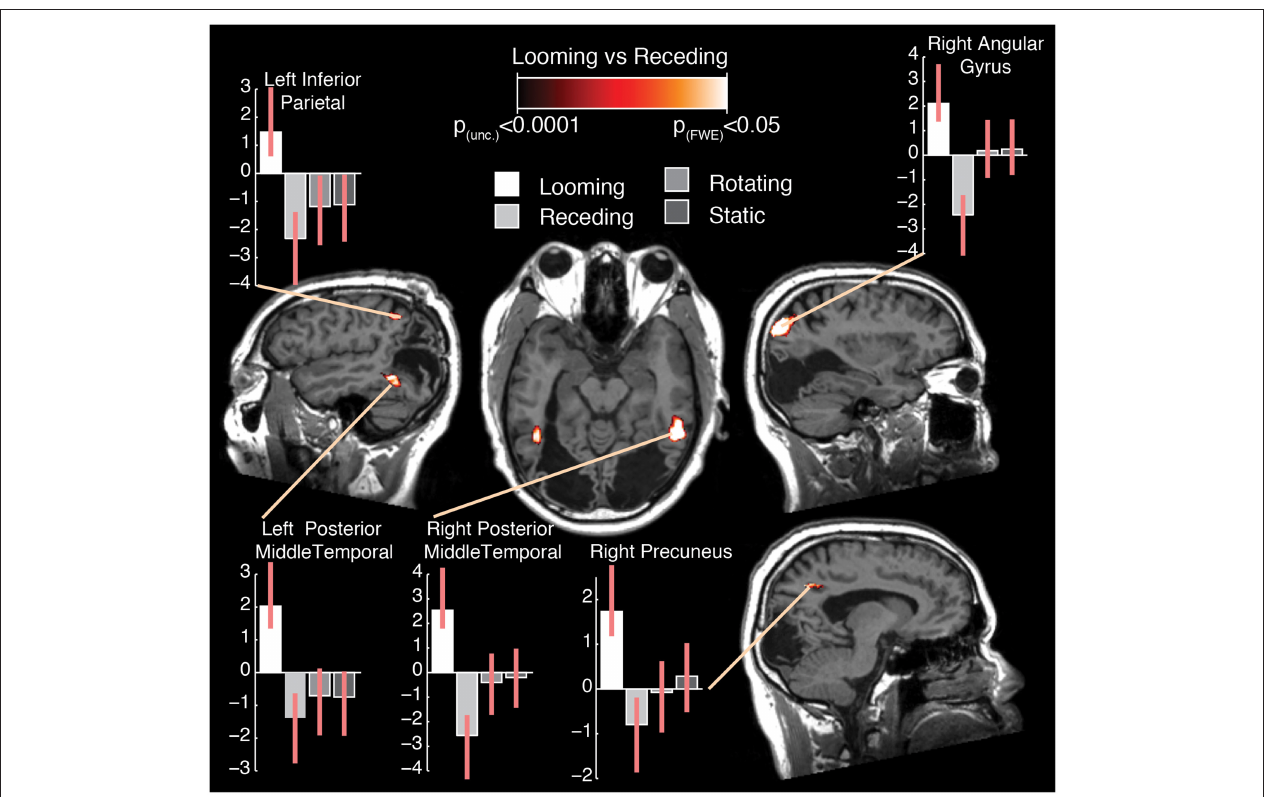
FIGURE 2 | Selected slices of the T1 anatomical scan, upon which are projected the clusters of significant BOLD response difference for the contrast Looming—Receding, thresholded at p (uncorrected) < 0.0001, with a cluster extent threshold ( k ) of 75 voxels. This value of k was empirically determined to be the level for which clusters composed of voxels at least meeting uncorrected p < 0.0001 would reach familywise-error corrected significance at the cluster level. No co-ordinates are given here as the images are presented in the patient’s native space. For comparison with previously published data and atlases, the co-ordinates of the activation differences are presented normalized to MNI-space in Table 1 . Graphs indicate the relative activation relative to baseline for each movement condition, error bars indicate 95% confidence intervals.